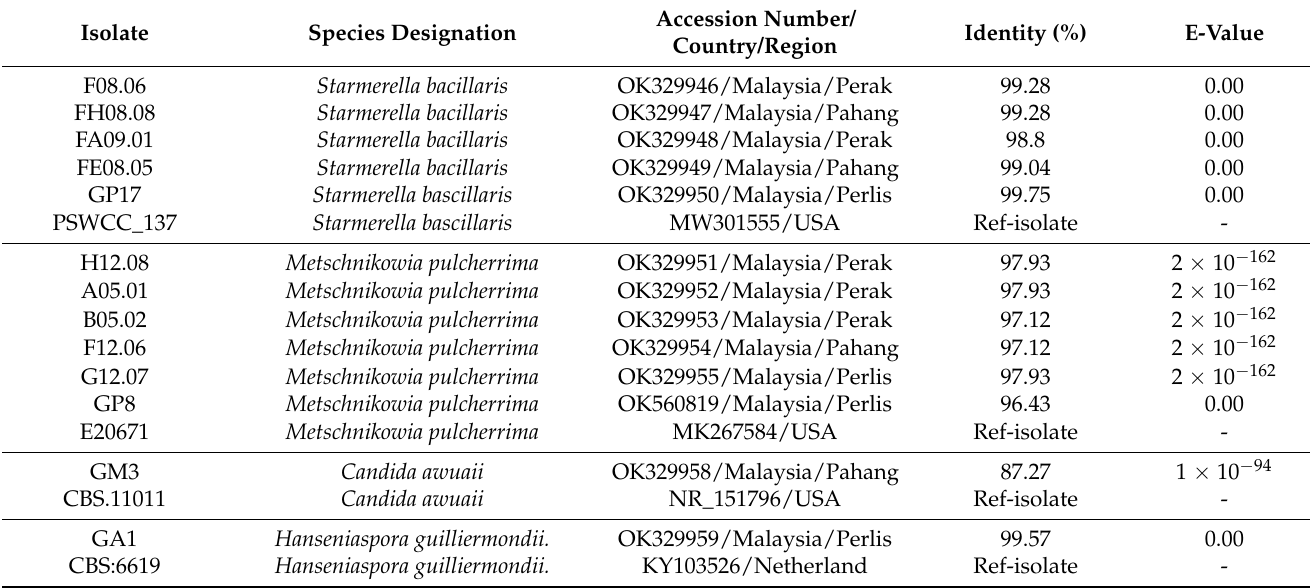
Figure 2. Occurrence of isolated yeast in three main regions of sampling (Pahang, Perak and Perlis). Vertical axis shows the occurrence percentage. Table 1. Identification of yeasts with potential for biological control. Values from pairwise sequence comparisons based on the highest sequence identity found in BLAST analysis. E-value (expectation value) represents the number of expected hits of similar quality (score) that could be found by